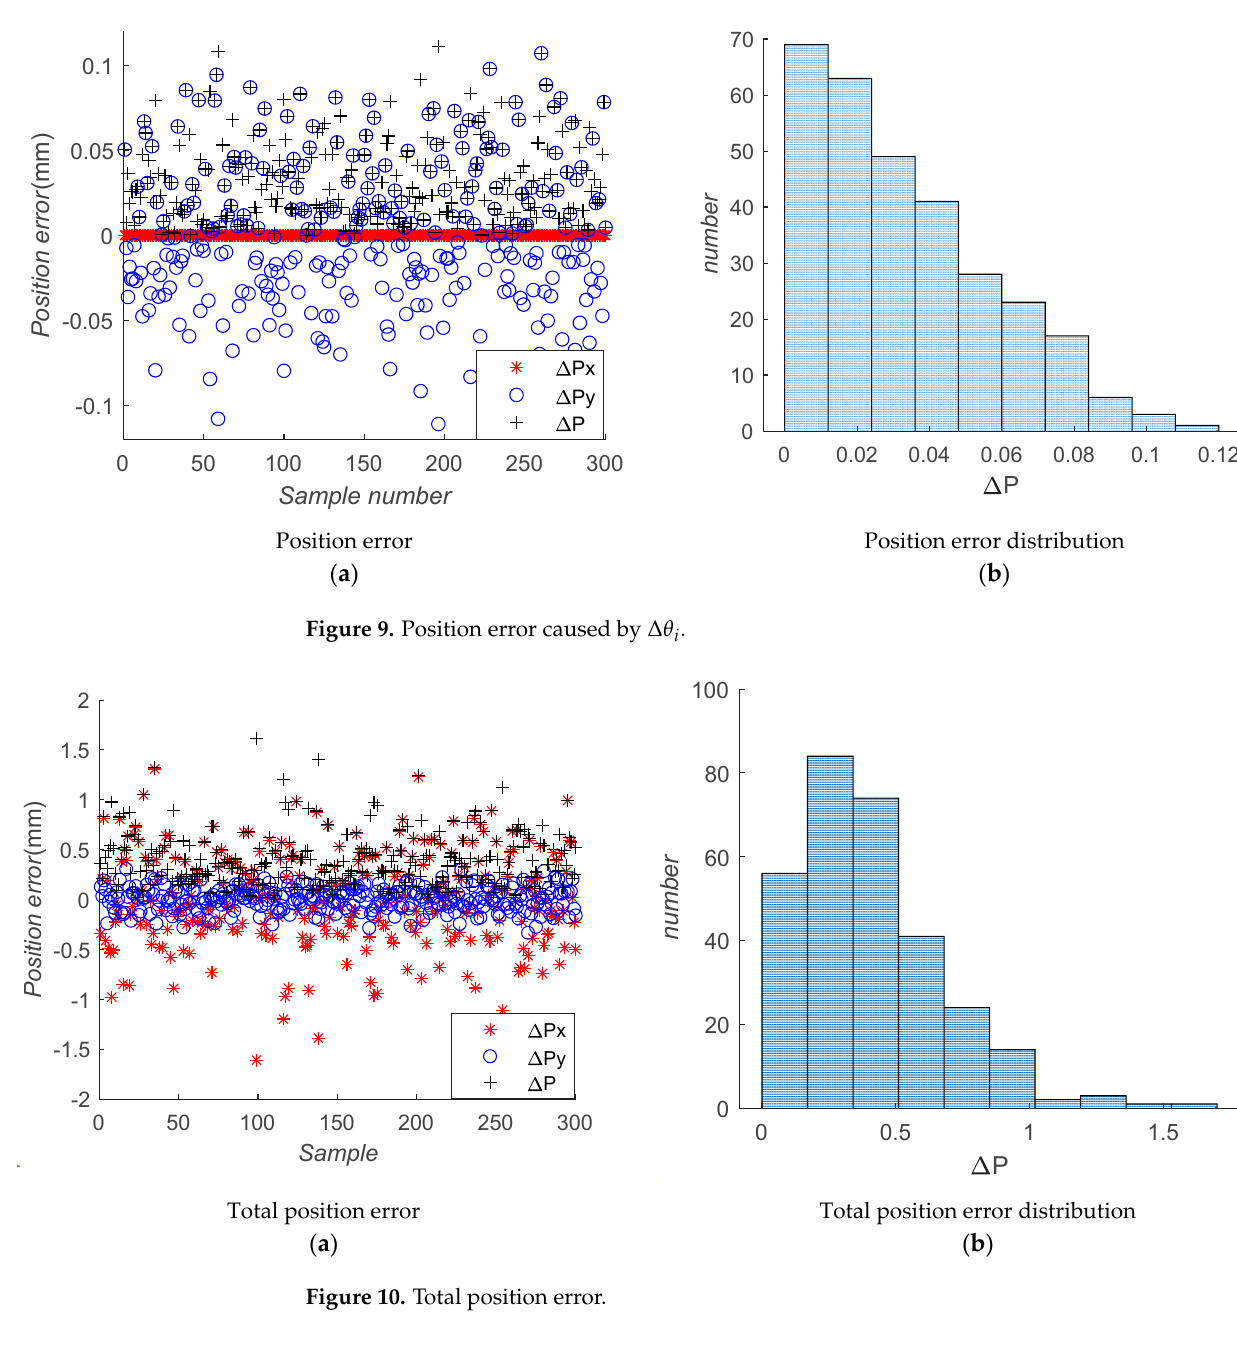
Figure 9. Position error caused by Δ θ i.